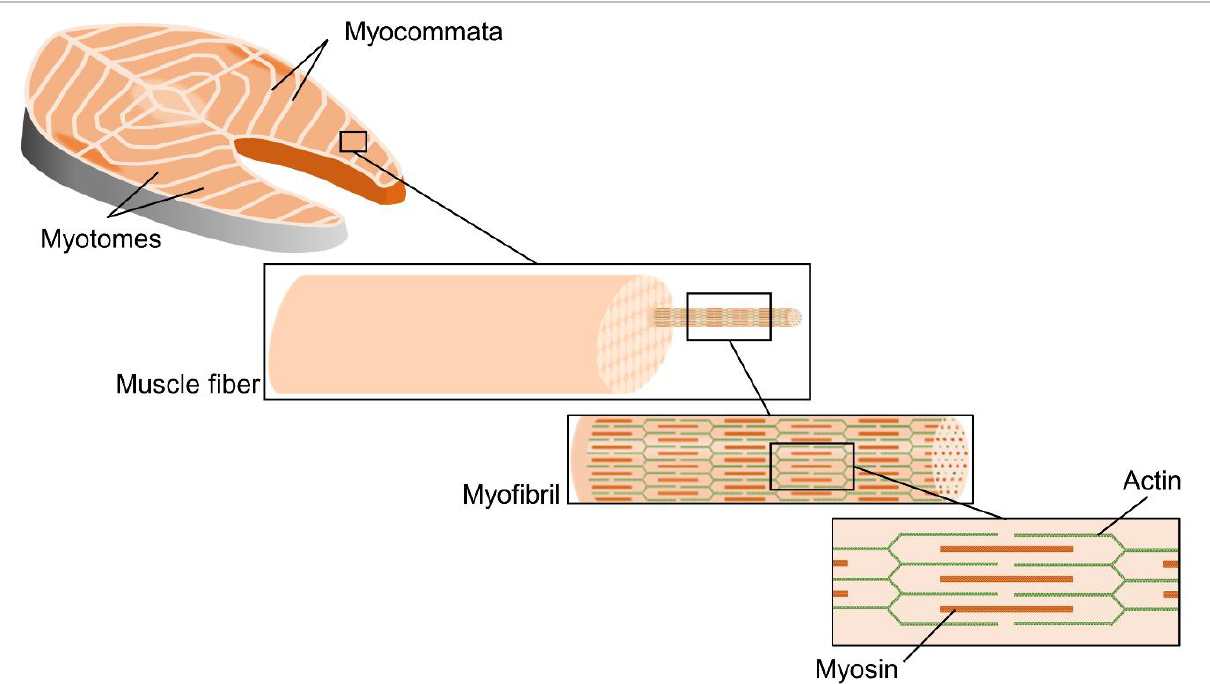
Figure 1. Structural organization within fish flesh.